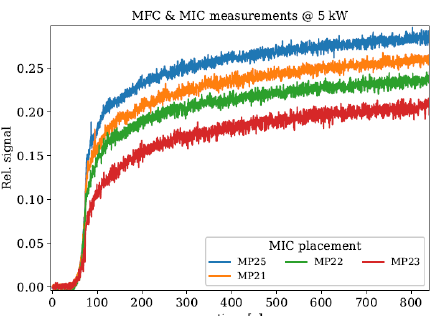
Fig. 3. Delayed gamma contribution measured with the MIC at 5 kW with regard to the position. Fig. 2. Measurement positions inside the TRIGA core.